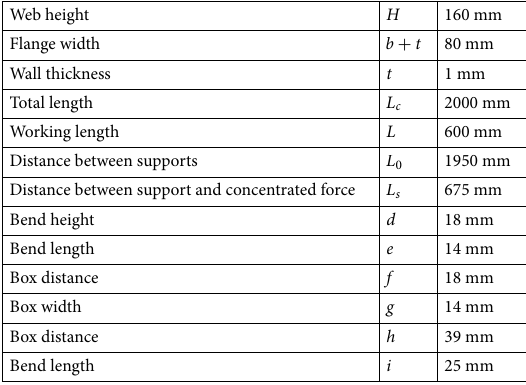
Table 1. Beam cross sections